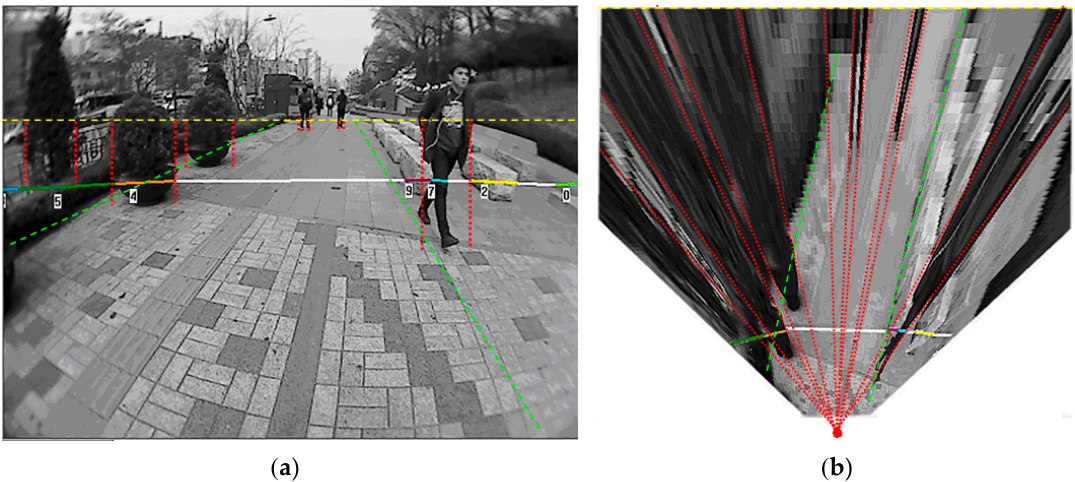
Figure 8. ( a ) Spatial distribution of the ground and object region in the original image domain; ( b ) Spatial distribution of the ground and object region in the top-view domain.